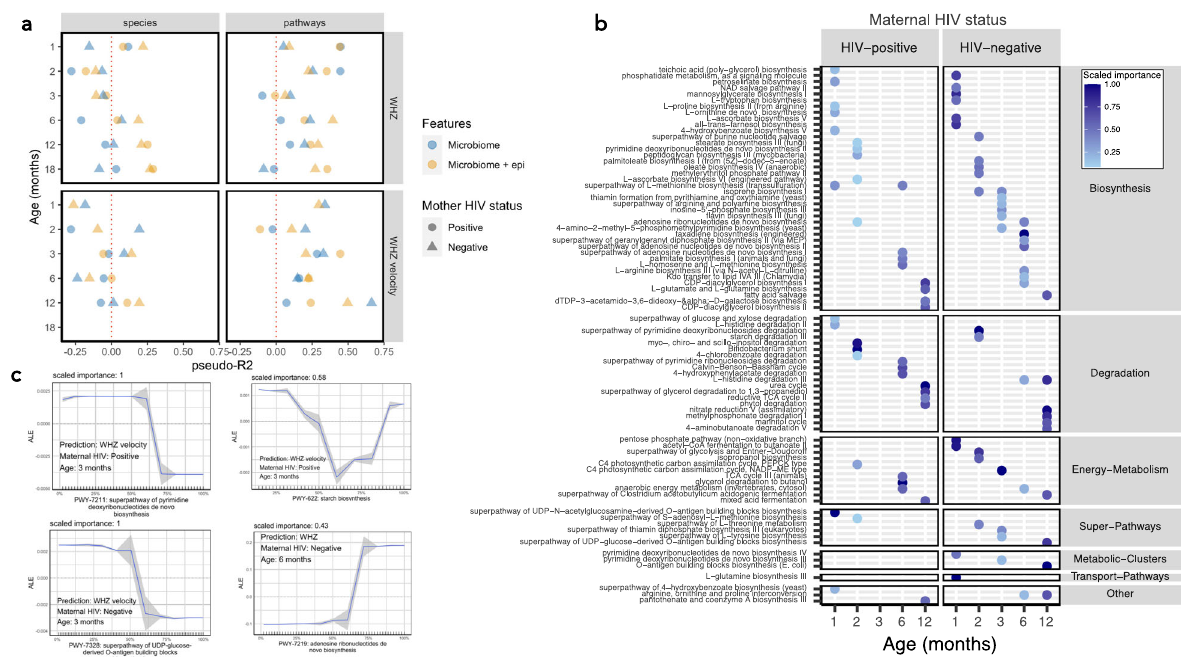
Fig. 6 | Prediction of attained WHZ and WHZ velocity using XGBoost models. PerformanceofXGBoost modelsas assessed bypseudo- R 2 values forprediction of attained WHZ and WHZ velocity (WHZ increase per day to next study visit) using species or metagenomic pathways, strati fi ed by age category and maternal HIV status ( a ). Models were run using microbiome features alone (species or metage- nomic pathways; blue points) and in combination with epidemiological variables (yellowpoints).Thetopranked pathwayspredicting WHZateachage categoryare plotted ( b ), strati fi ed by maternal HIV status and coloured by scaled importancein the XGBoost model (darkness of blue shading indicates feature ranking in the model). Accumulated effect plots (ALE) of representative pathways ranking highly